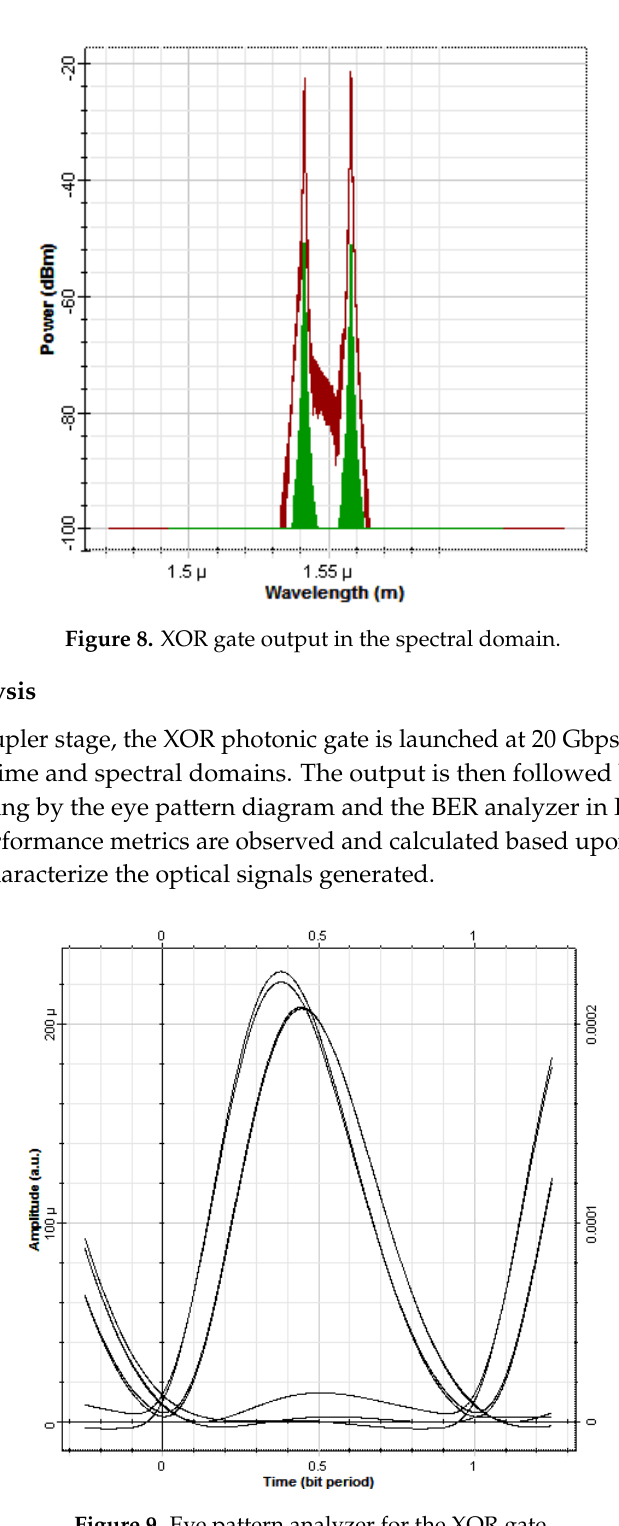
Figure 9. Eye pattern analyzer for the XOR gate.